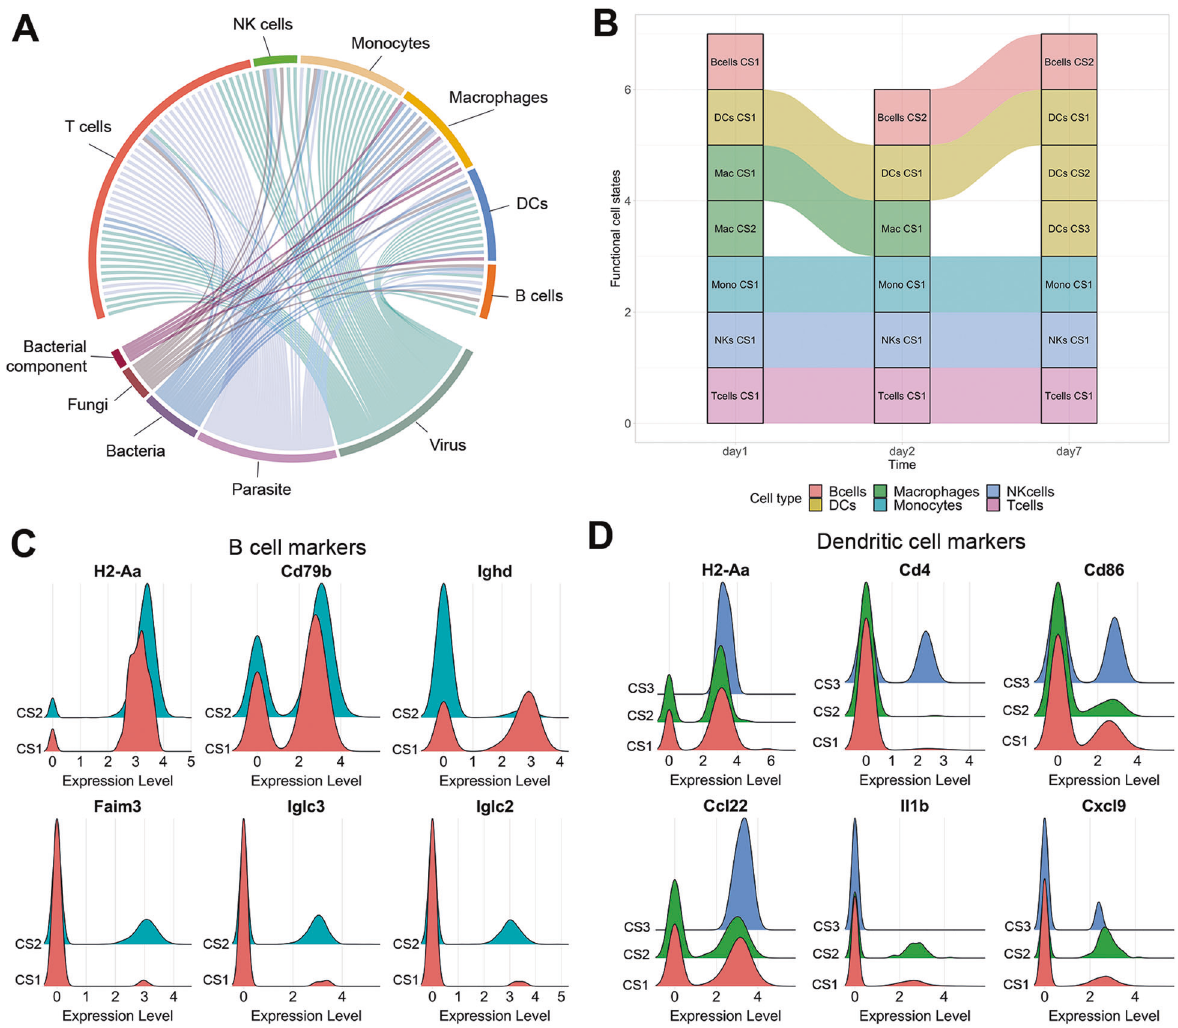
Fig. 5 Metadata analysis of functional cell states. A Chord diagram representing the common and unique cell states across pathogen types infections. B Alluvial plot of the functional states identi fi ed for the six immune cell types infected by Mycobacterium smegmatis across three timepoints. CS functional Cell State, DCs dendritic cells, Mac macrophages, Mono monocytes, NKs Natural Killer cells. C , D Markers expression for ( C ) the two B cells and ( D ) the three DCs functional cell states shown in ( B ). Distributions displayed include all applicable